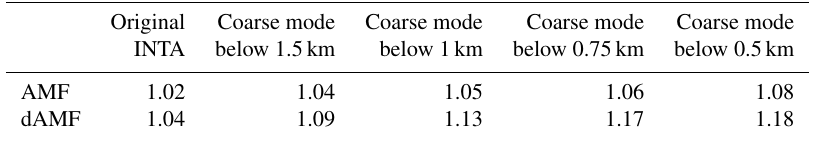
Figure A33. (a) Modified aerosol profiles for 8 July assuming that the coarse-mode aerosol is only located in the lowest part of the atmo- sphere. (b) Ratios of the (d)AMFs calculated for the modified profiles compared to the dAMFs for the standard settings. With decreasing layer height the (d)AMFs increase systematically, because the aerosol extinction close to the surface decreases. (c) Comparison of the measured elevation dependence of the O 4 dAMFs for the period 07:00–11:00 on 8 July and simulation results for the different profiles. Table A29. Ratios of the (d)AMFs for the modified profiles vs. those of the standard settings.